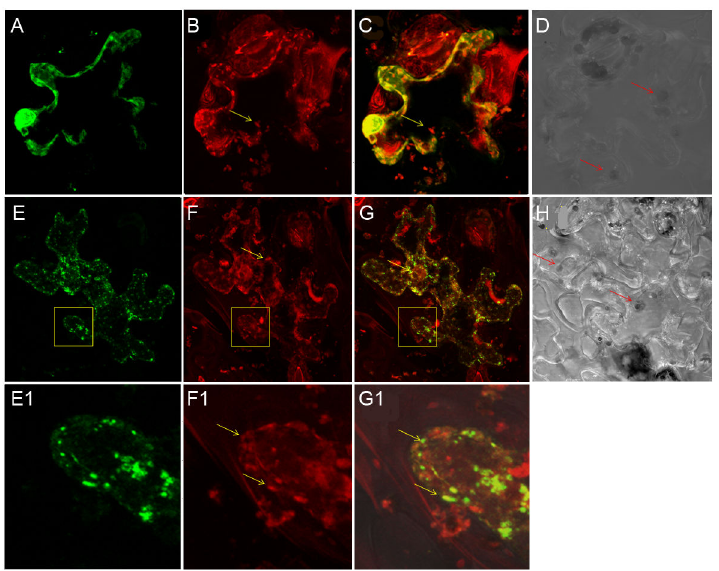
Figure 5. Mitochondrial localization of the Las autotransporter LasA expression and MitoTracker labeling were detected in tobacco leaves infiltrated with pGDY and pGDY- lasA respectively. A , E : GFP detection with 505-530 nm BP filter; B , F : MitoTracker detection with 560 nm LP filter; C , G : merged scans; D , H : differential interference contrast (DIC) micrographs of tobacco cells with chloroplasts (red arrows). E1, F1, G1 : magnifications of yellow boxes in panels E, F and G. Mitochondria (yellow arrows). doi: